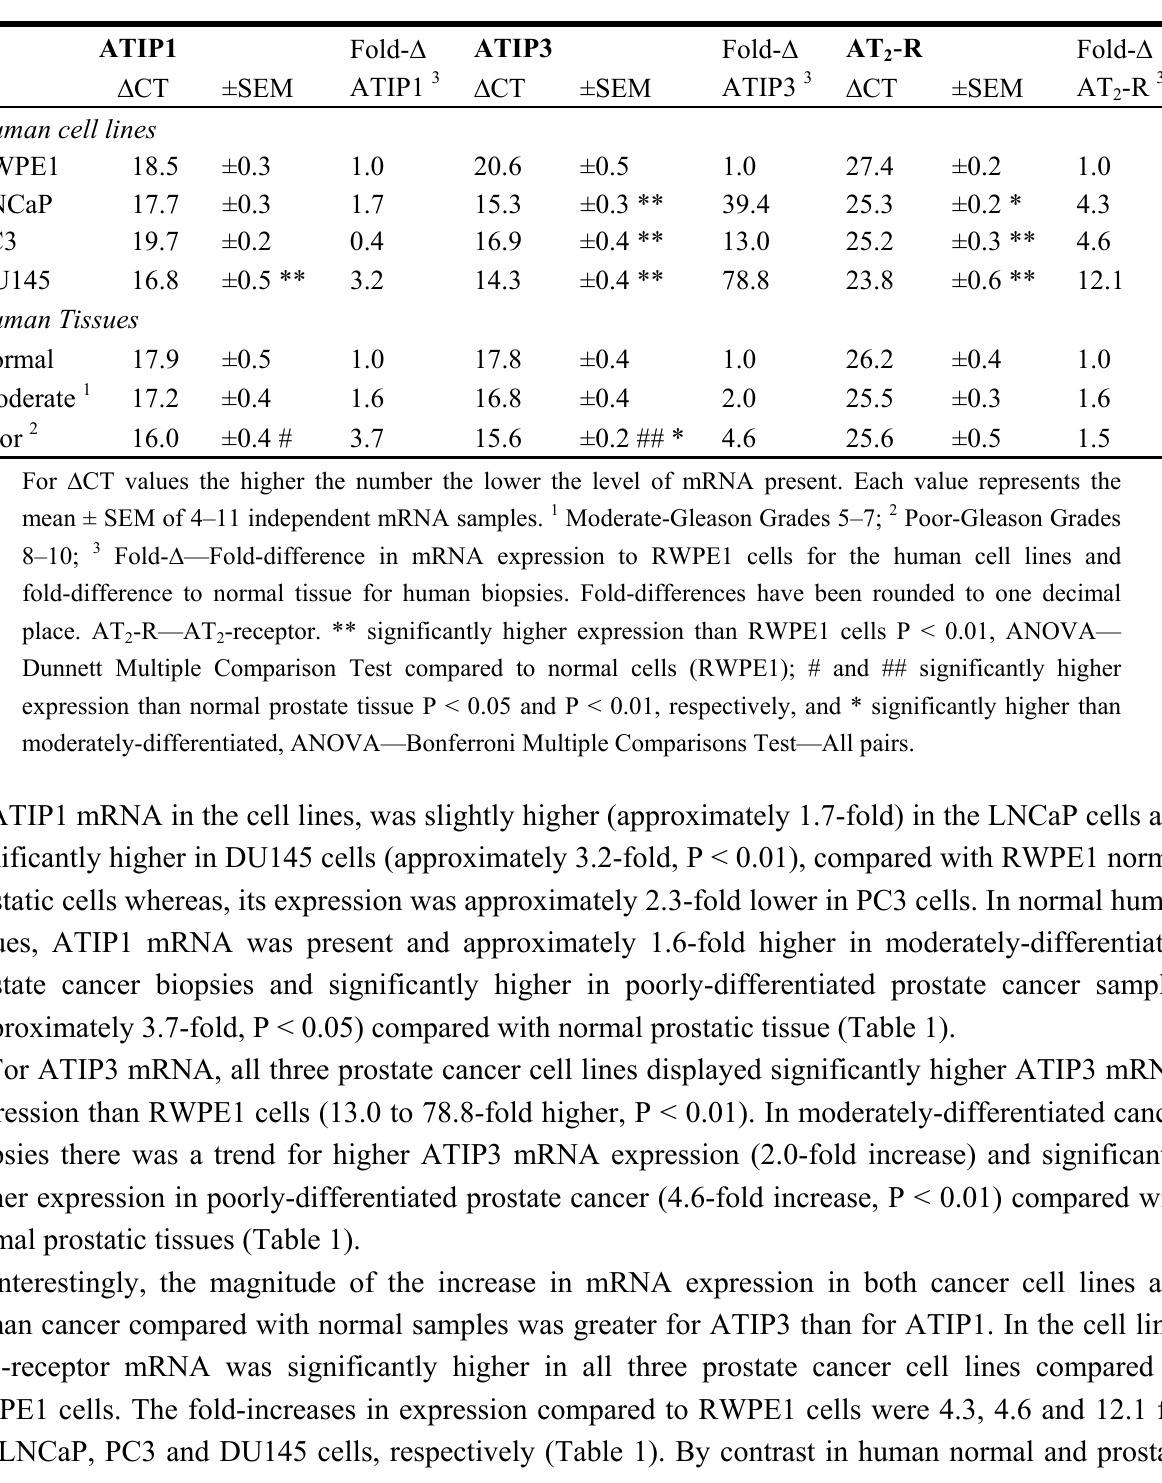
-receptor mRNA in human prostate cell 2